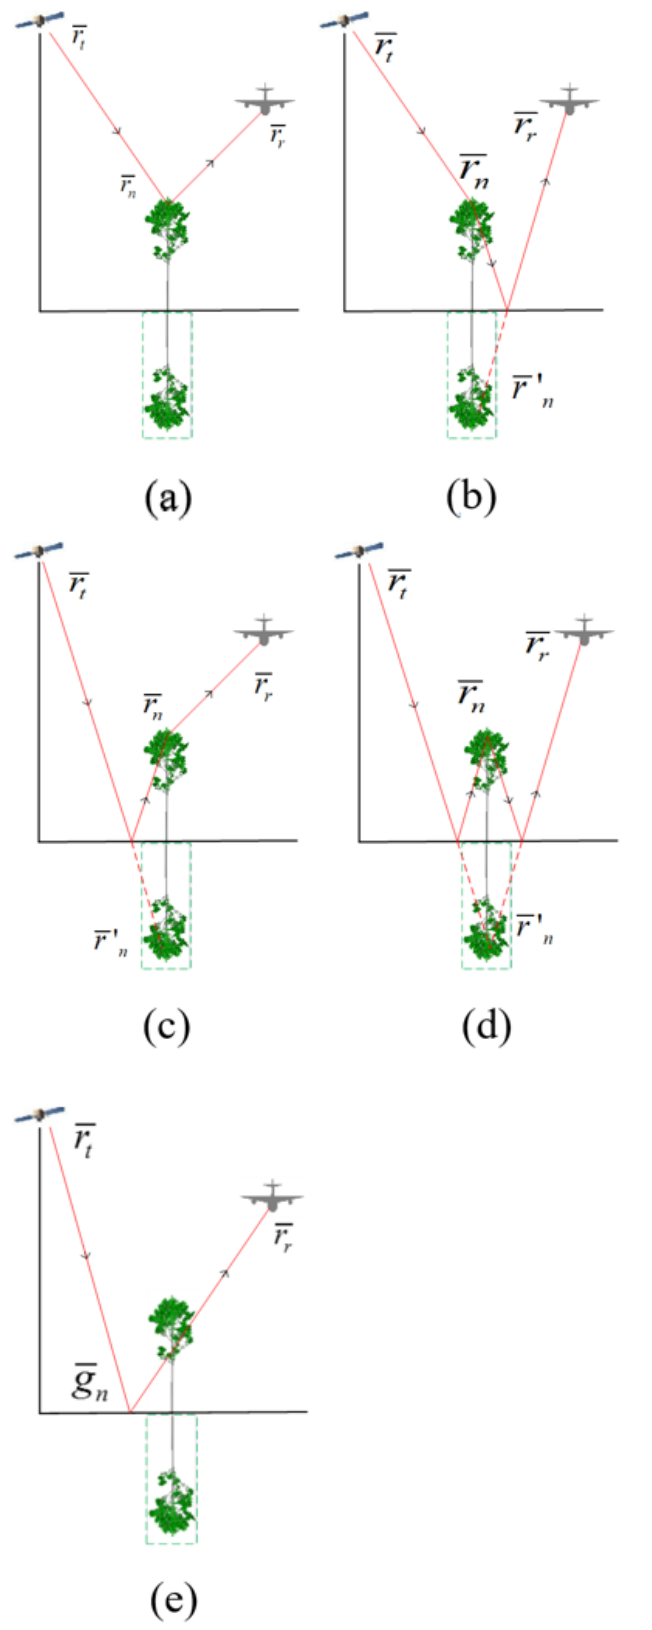
Figure 1. The five scattering components: ( a ) Direct scattering from scatterer; ( b ) Single bounce from scatterer to ground; ( c ) Single bounce from ground to scatter; ( d ) Double bounce from ground, scatter to ground; ( e ) Direct scattering from ground.